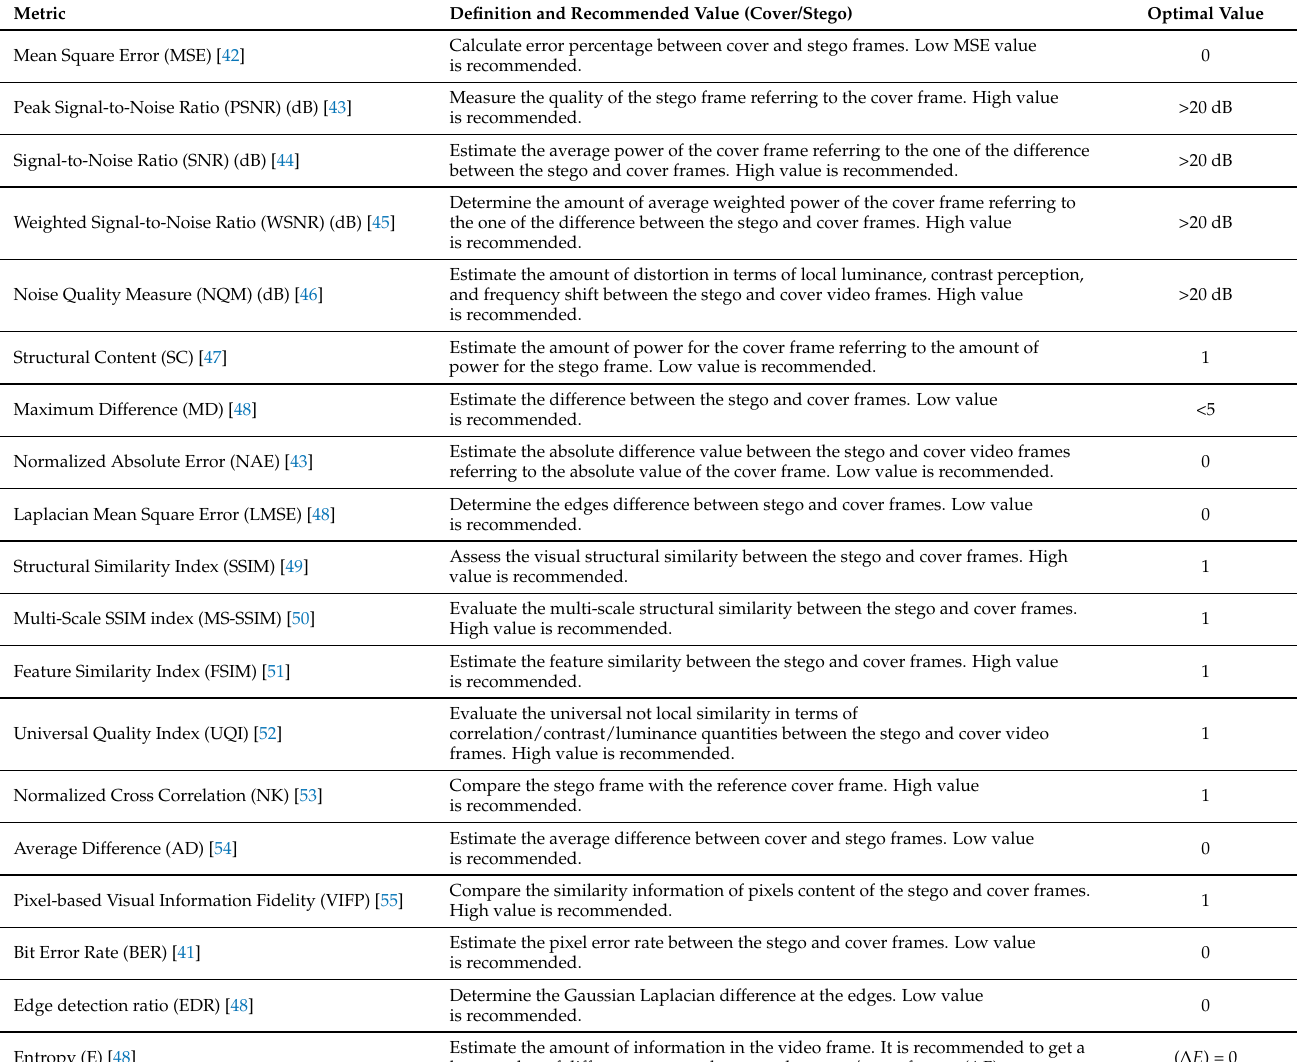
Table 3. The employed visual objective quality assessment